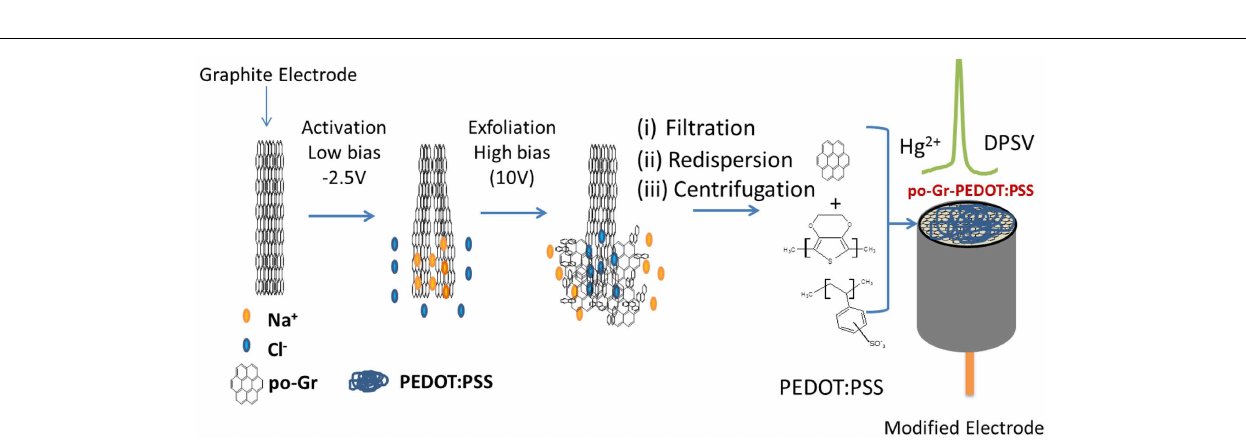
FIGURE 1 | Schematic representation of electrochemical synthesis of po-Gr and electrochemical detection of mercury (Hg 2 + ) at po-Gr-PEDOT:PSS film-coated electrode by differential pulse stripping voltammetry (DPSV) .